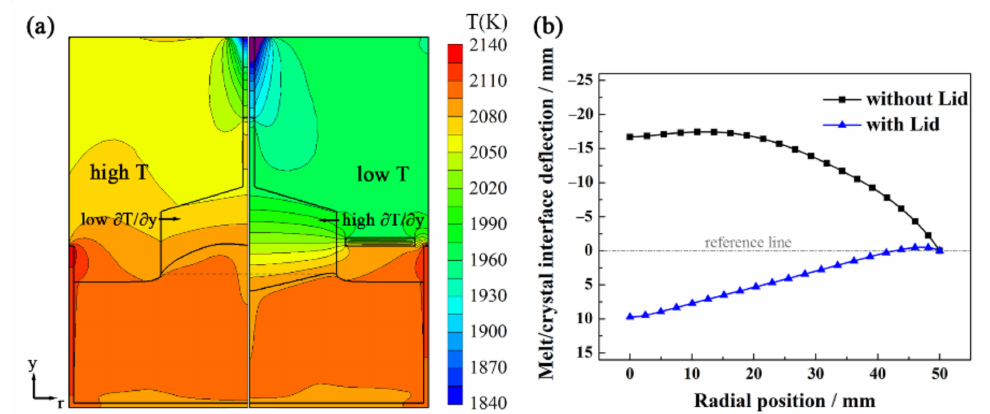
Figure 2. ( a ) Temperature distributions of the CZ system. Left: without, and right: with insulation lid. ( b ) The corresponding melt/crystal interface shapes in ( a